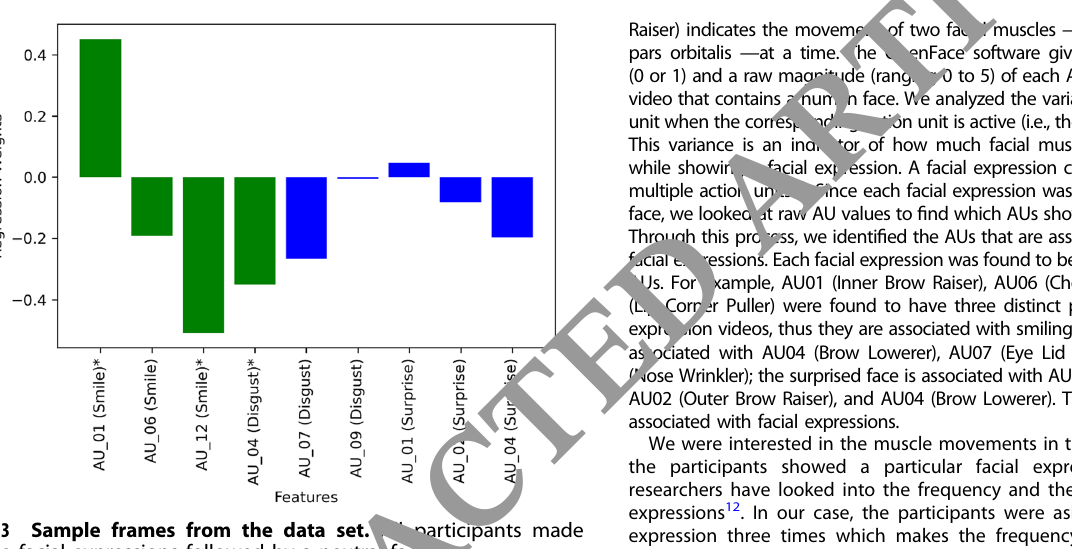
Fig. 2 A two-dimensional visualization of the nine action units (AUs) after applying the principal component analysis (PCA). The dots on the surface represents each participant. The participants are clustered into three groups using K-means represented by three colors. The bold round dots represents the cluster center of the three clusters. The proportion of individuals with Parkinson ’ s disease in each group differed with 75.7% of individuals in the red cluster having Parkinson ’ s disease.